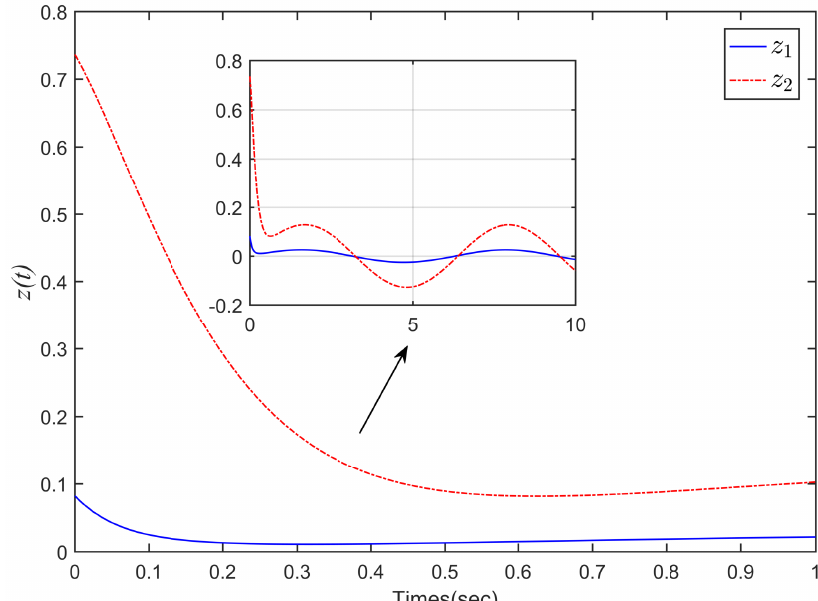
Figure 9. Controlled Output.